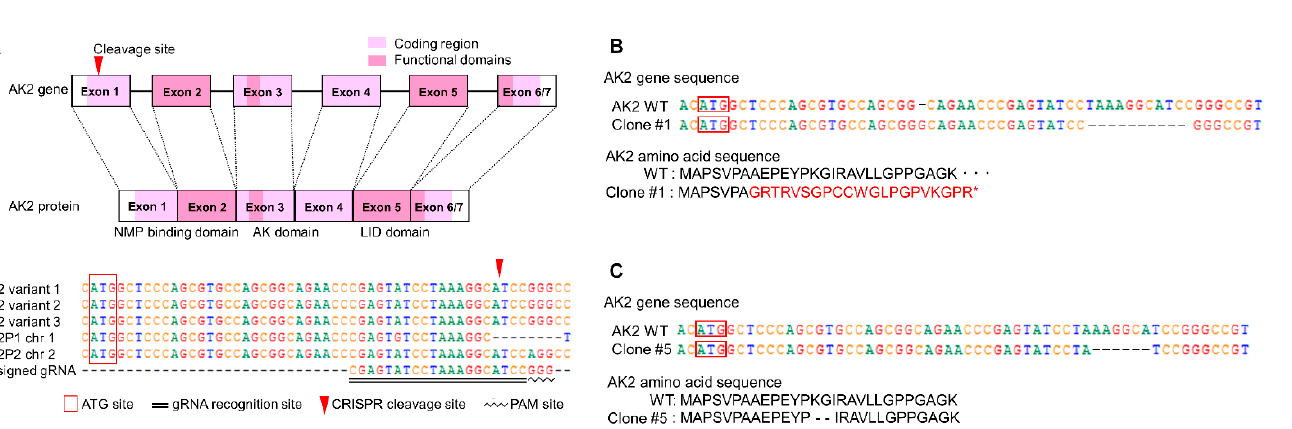
Figure 1. The scheme of adenylate kinase 2 (AK2) gene sequences in clones generated by clustered regularly interspaced short palindromic repeats/Cas9 (CRISPR/Cas9) ( A ) The schematic diagram of the CRISPR/Cas9-targeted site on AK2.AK2 has six or seven exons. The pale pink area indicates the coding region and the dark pink areas indicate functional domains of the AK2 protein. The red arrowhead indicates the Cas9/guide RNA (gRNA)-targeted cleavage site. The bottom shows a sequence alignment of the AK2 gene from AK2 variants 1, 2, 3, and AK2 pseudogene 1 (AK2P1), 2 (AK2P2), and the designed gRNA. The double underline indicates the designed gRNA and the wavy line indicates the protospacer adjacent motif (PAM) site. Chr, chromosome. ( B ) DNA and amino acid mutation sites in AK2 in clone #1 generated from the first trial. Clone #1 was obtained after the first trial of CRISPR/Cas9 treatment. The red box shows the ATG start site of the AK2 gene. Red letters of amino acid sequence show the difference between wild-type (WT) and the clone. The as- terisk indicates stop codon. ( C ) DNA and amino acid mutation sites in AK2 in clone #5 generated from the second trial. Clone #5 was obtained after the second trial of CRISPR/Cas9 treatment. The red box shows the ATG start site of the AK2 gene. Red letters of amino acid sequence show the difference between WT and the clone. Table 1. Mutation sites of clones by CRISPR/Cas9. Clone